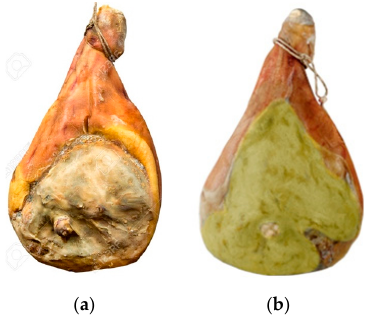
Figure 1. Short ‐ seasoned dry ‐ cured ham (SSDCH) ( a ) without; ( b ) with A. westerdijkiae. Figure 1. Short-seasoned dry-cured ham (SSDCH) ( a ) without; ( b ) with A.